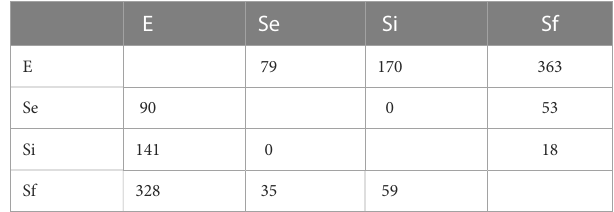
TABLE 1 Number of signi fi cant up/downregulated genes at each analyzed time